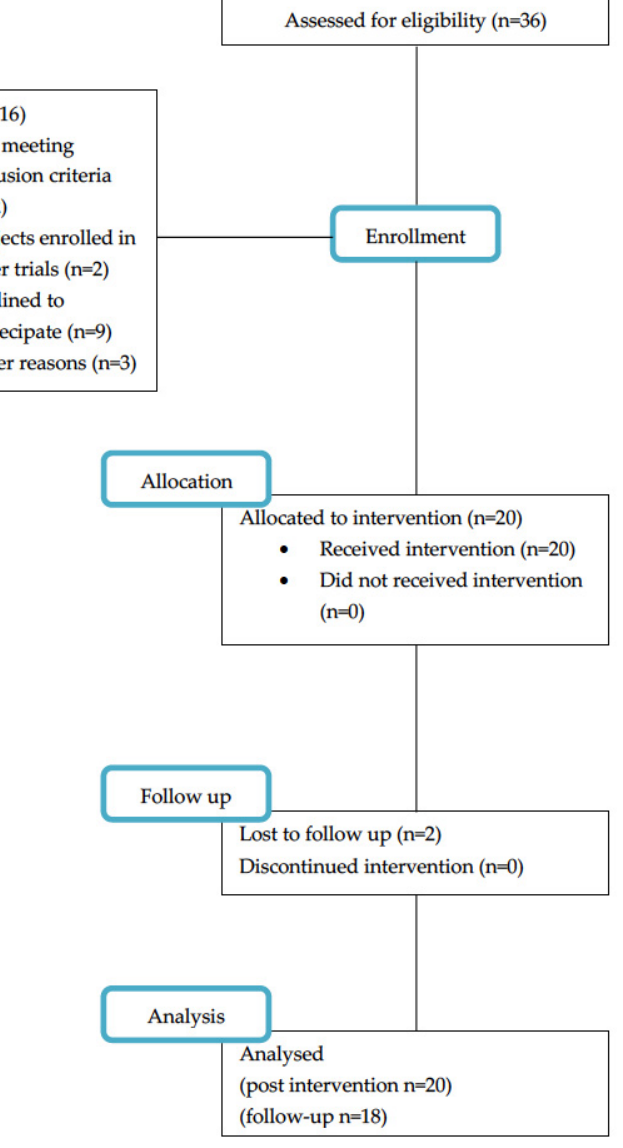
Figure 1. Study Figure 1. Study flow.